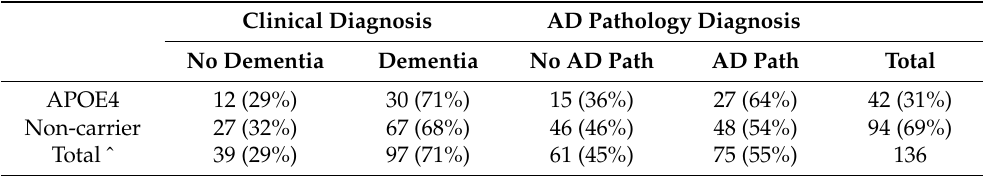
Table 2. APOE4 status of those with clinical dementia or an AD pathology diagnosis in the MSBB cohort. Clinical Diagnosis AD Pathology Diagnosis